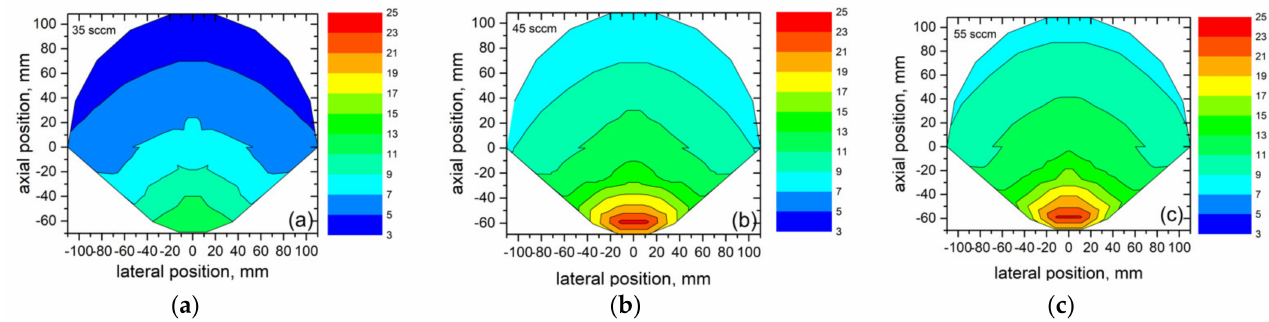
Figure 11. Measurement results for plasma potential. ( a )—35 sccm; ( b )—45 sccm; ( c )—55 sccm. Axial positions are given relative to the rotation axis of the linear stage. Thruster cut-off is situated at the position − 70 mm.